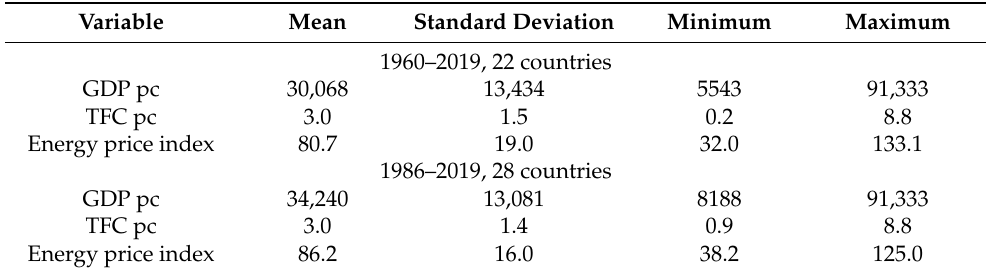
Table 1. Summary statistics for two balanced